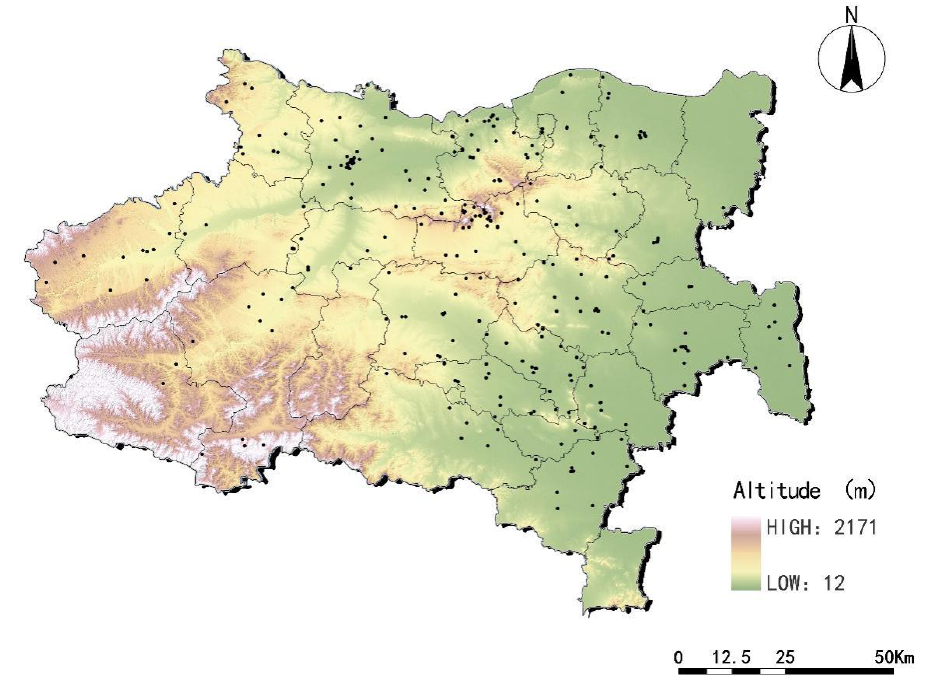
Figure 10. Spatial distribution of historical buildings in different altitude ranges.